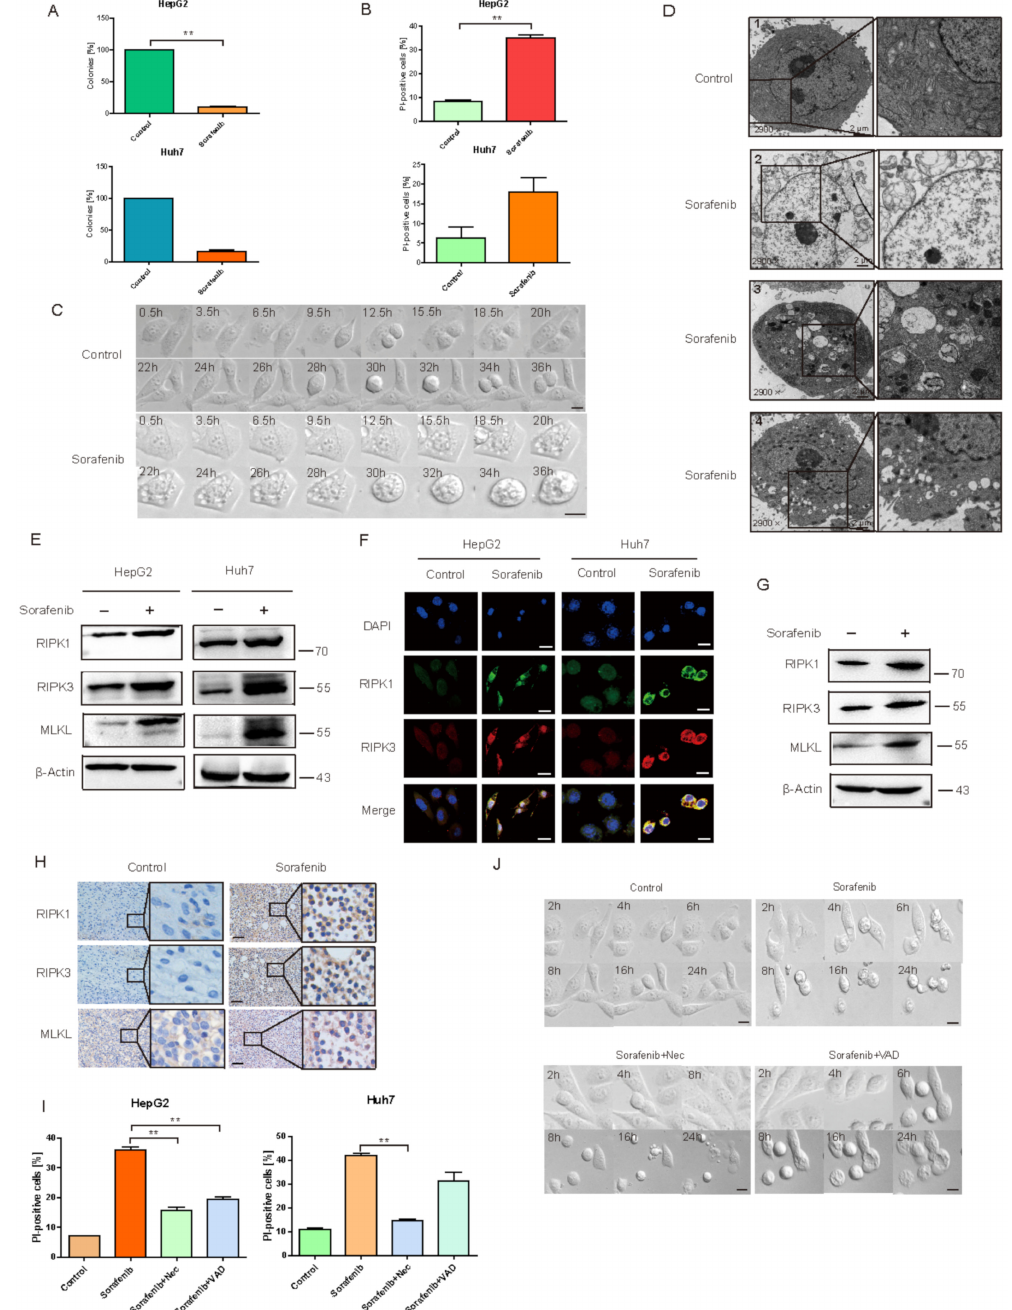
Figure 1. Sorafenib Induced HCC Necroptosis. ( A ) The inhibitory effect of Sorafenib on Hepatocellular carcinoma cell lines by Soft Agar Assay. The results were shown as mean ± SEM from three independent experiments. ** p < 0.01. ( B ) Detection of PI-positive cells in Huh7 and HepG2 cells with Sorafenib treatment by Flow Cytometry. The results were shown as mean ± SEM from three independent experiments. ** p < 0.01. ( C ) To observed the morphological changes of HepG2 cells by Live Cell Imaging System. Scale bar = 40 µ m. ( D ) The different types of death in HepG2 cells induced by Sorafenib observed by Transmission Electron Microscope. ( E , F ) The expressions of necroptosis pathway in hepatocellular carcinoma cell lines after Sorafenib treated detected by Western blot and Immunofluorescence. Scale bar = 40 µ m. ( G , H ) The expression of RIPK1, RIPK3 and MLKL were dectected in PDX-xenograft respectively by Western blot and IHC. Scale bar = 800 µ m. ( I ) Detection of PI positive cells by flow cytometer to observe the dead cell when Nec and VAD exists. The results were shown as mean ± SEM from three independent experiments. ** p < 0.01. ( J ) Live cell Imaging System observed morphological changes in HepG2 cells when Nec and VAD exist. Scale bar = 40 µ